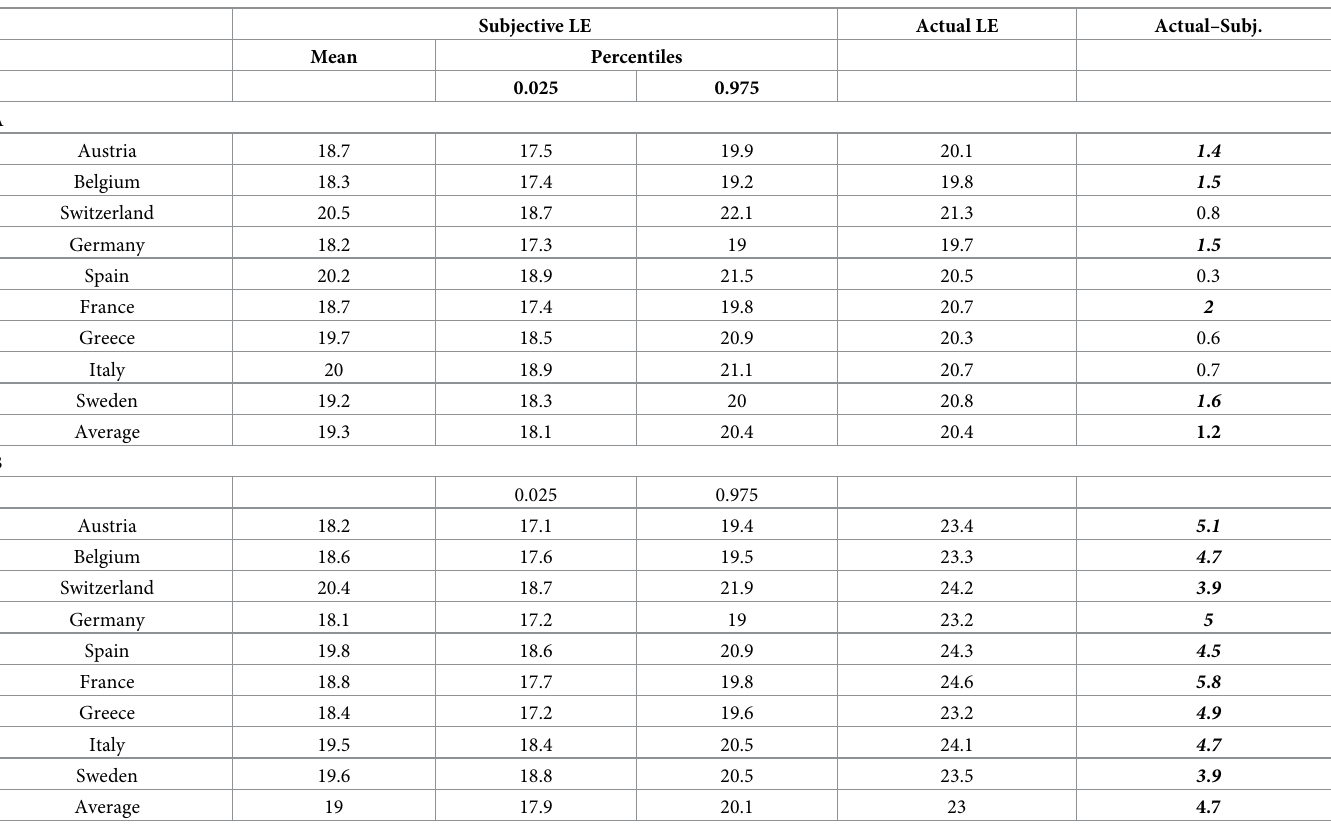
Table 3. a) Segmented subjective and actual life expectancy (LE) and percentiles of the subjective LE, males, 9 European countries,